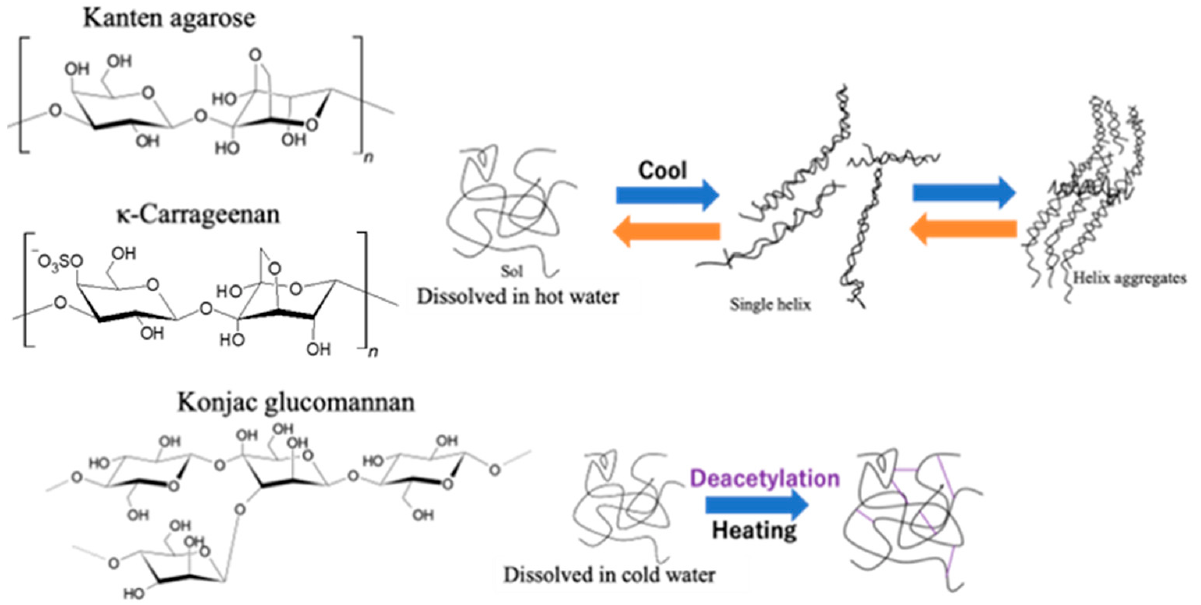
Figure 3. Gelation illustration of Kanten agarose, κ -carrageenan, and konjac glucomannan hydro- gels.